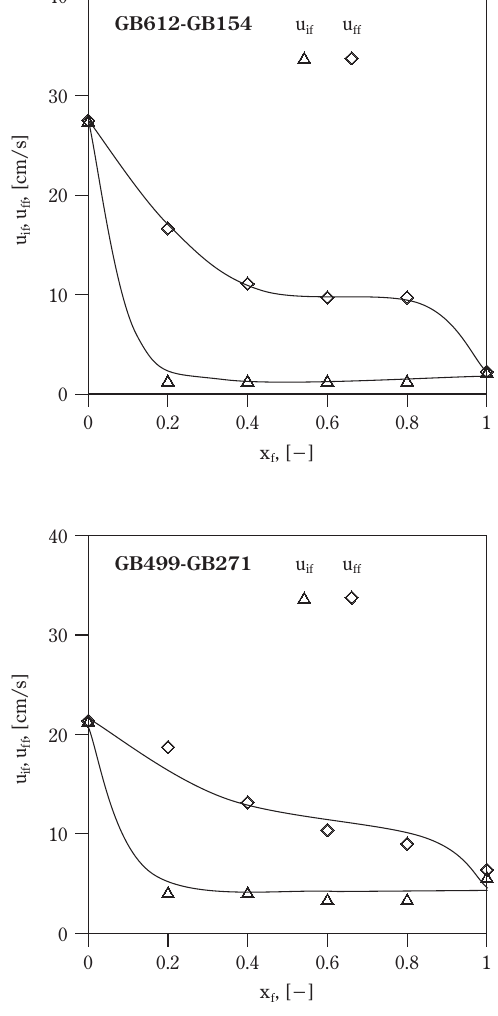
Fig. 9 Fluidization velocity range of size segregating mixtures. Well-mixed beds.